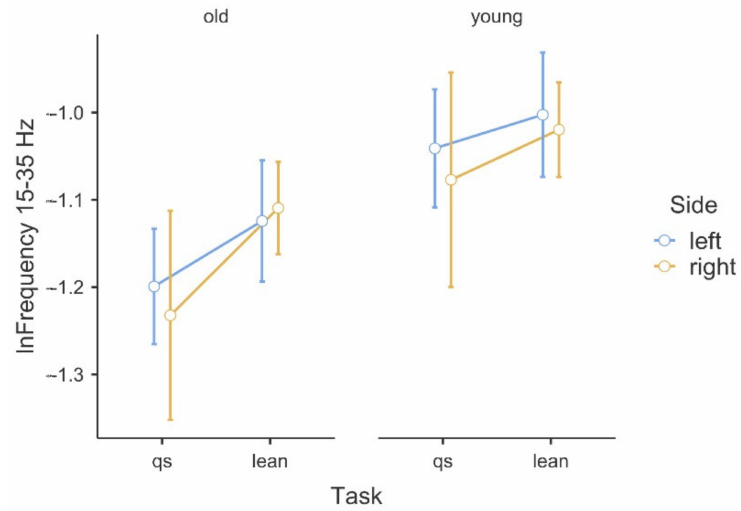
Figure 2. Illustration of the asymmetry of the logarithmic beta band frequency data in the (qs/lean) tasks in the comparison of the two groups. Table 2. Results of the significance analysis of differences of the R2b parameter, between the study group of young and older people, analyzed by Independent Samples t -Test. T p Cohen’s d R2b − 3.34 0.002 − 1.01